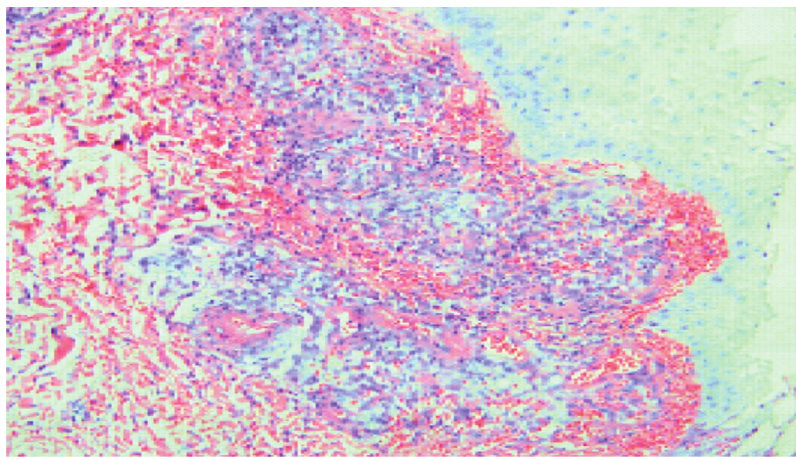
Figure 2: Histopathology exam showing diffuse neutrophilic and lymphocytic